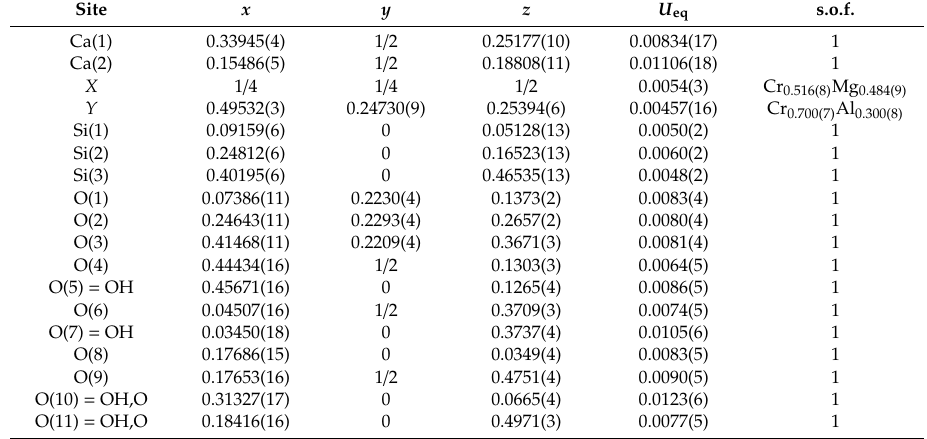
Table 4. Coordinates and equivalent displacement parameters ( U eq , in Å 2 ) of atoms and site occupancy factors (s.o.f.) for shuiskite-(Cr).